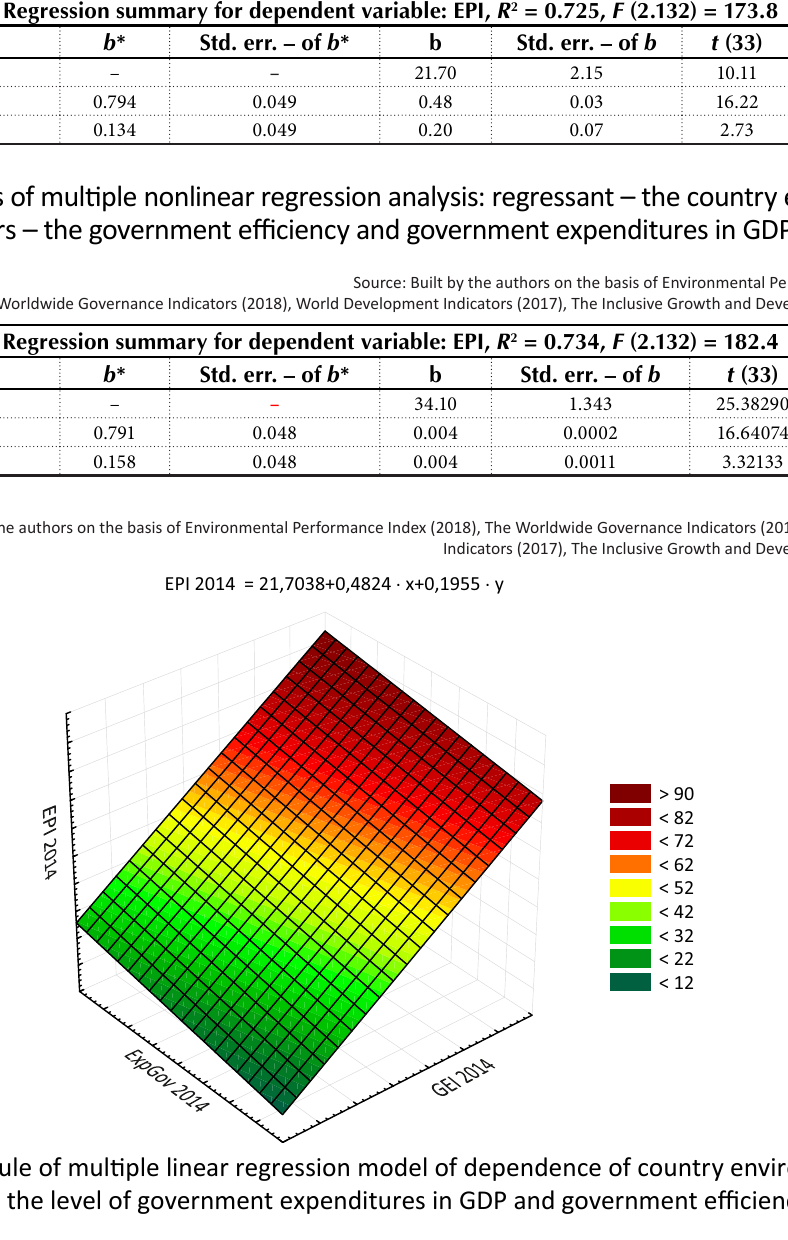
Table 6. Results of multiple linear regression analysis: regressant – the country environmental state, regressors – the government efficiency and the level of government expenditures in GDP